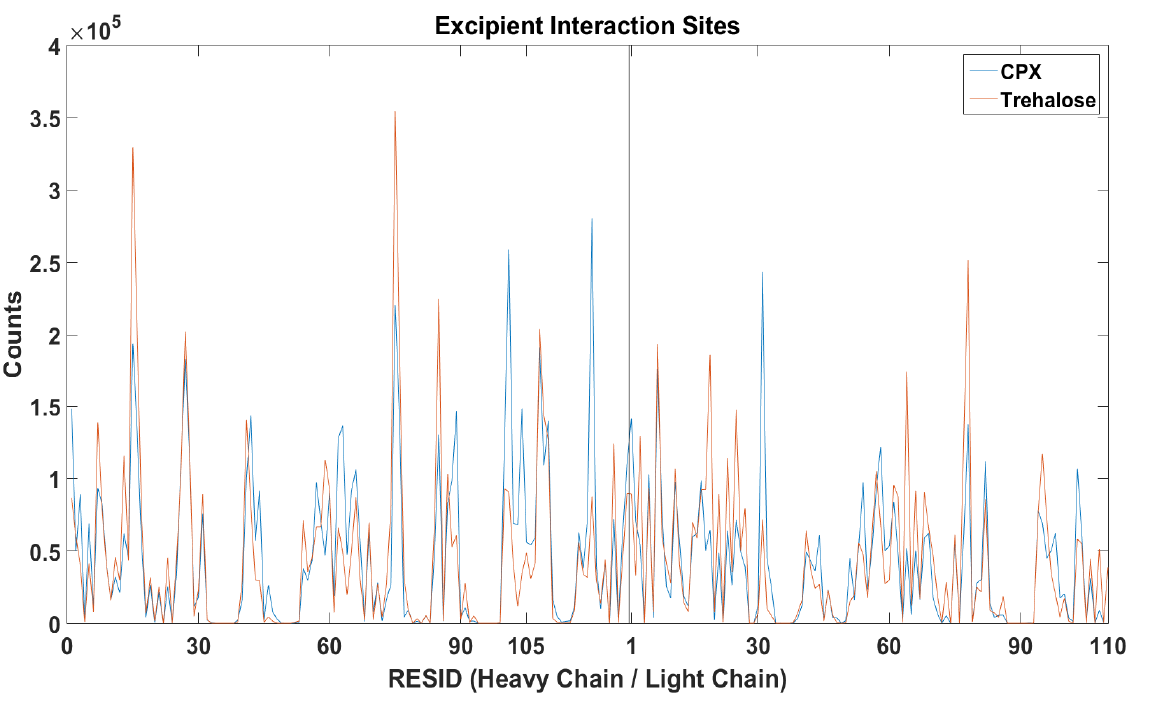
Figure 7. The locations of Compound X and trehalose were tracked with respect to the mAb1 Fv fragment Compound X was found to bind to LEU105 on heavy chain more frequently than trehalose.